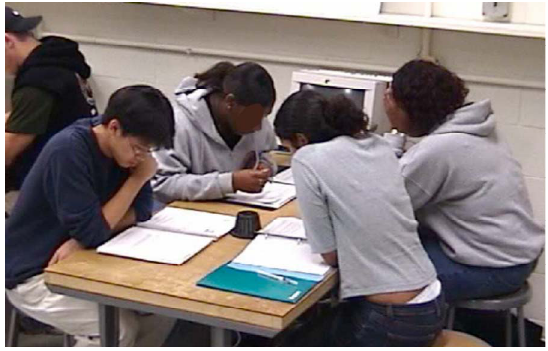
Video 1 (cid:1) Color (cid:2) Verbal and nonverbal cues indicate reading from a shared text.